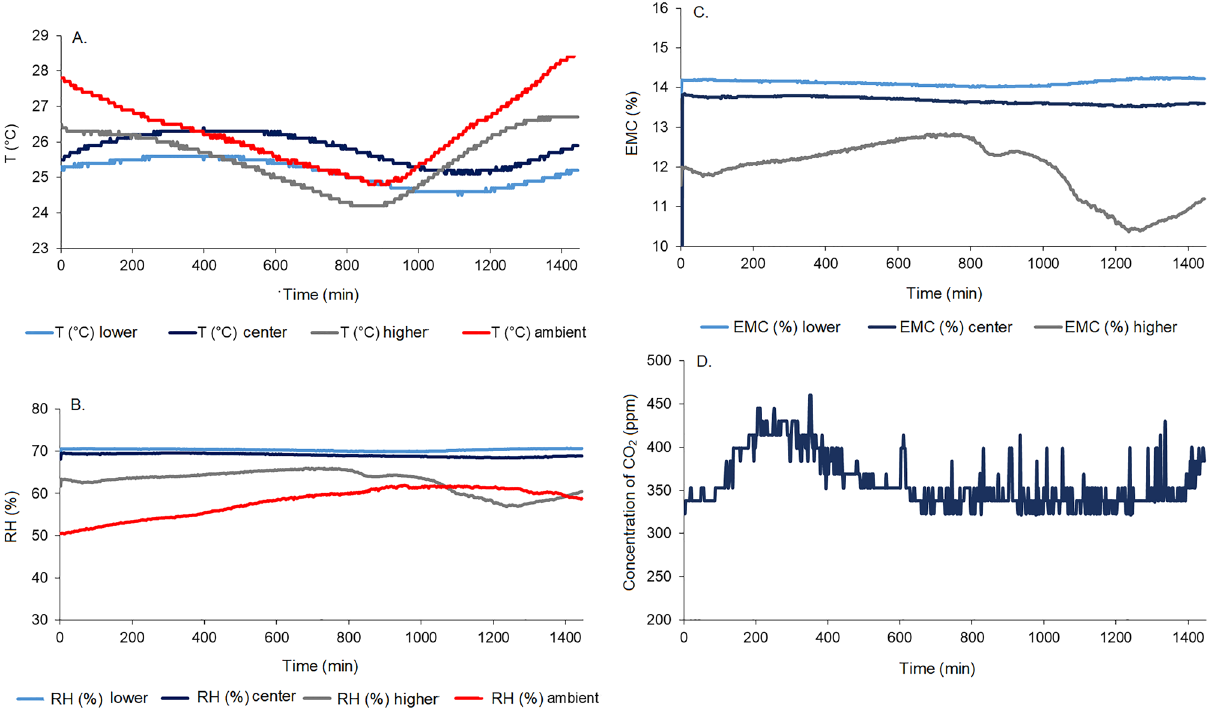
Figure 4. Monitoring temperature ( A ), relative humidity ( B ), equilibrium moisture content ( C ), carbon dioxide ( D ) of the intergranular air in the corn grain mass at 12% moisture content (w.b.) over